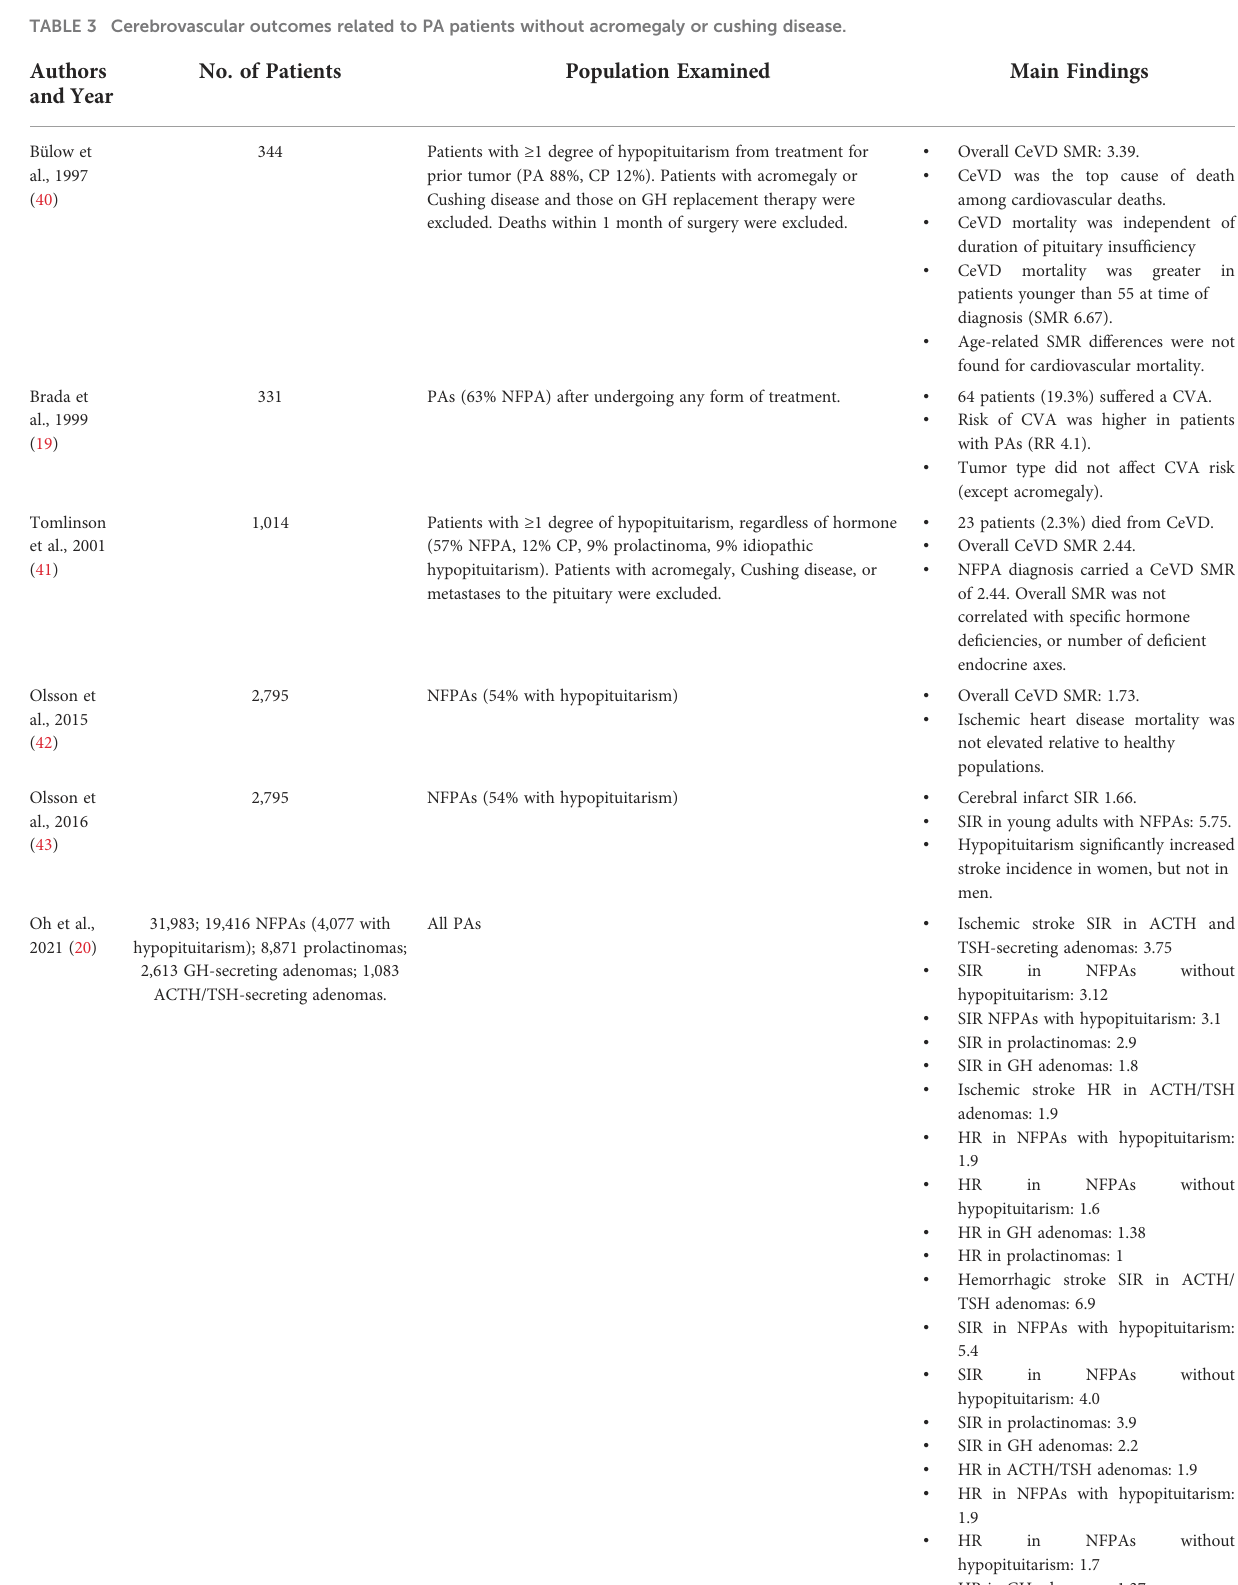
TABLE 3 Cerebrovascular outcomes related to PA patients without acromegaly or cushing